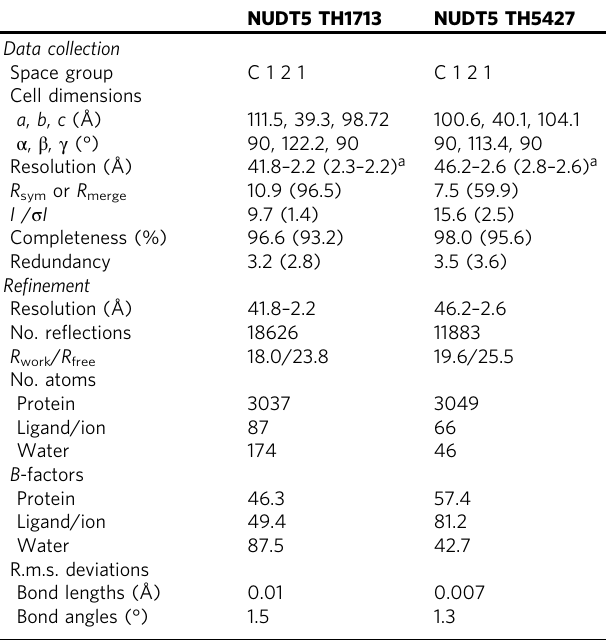
Table 1 Crystallography data collection and re fi